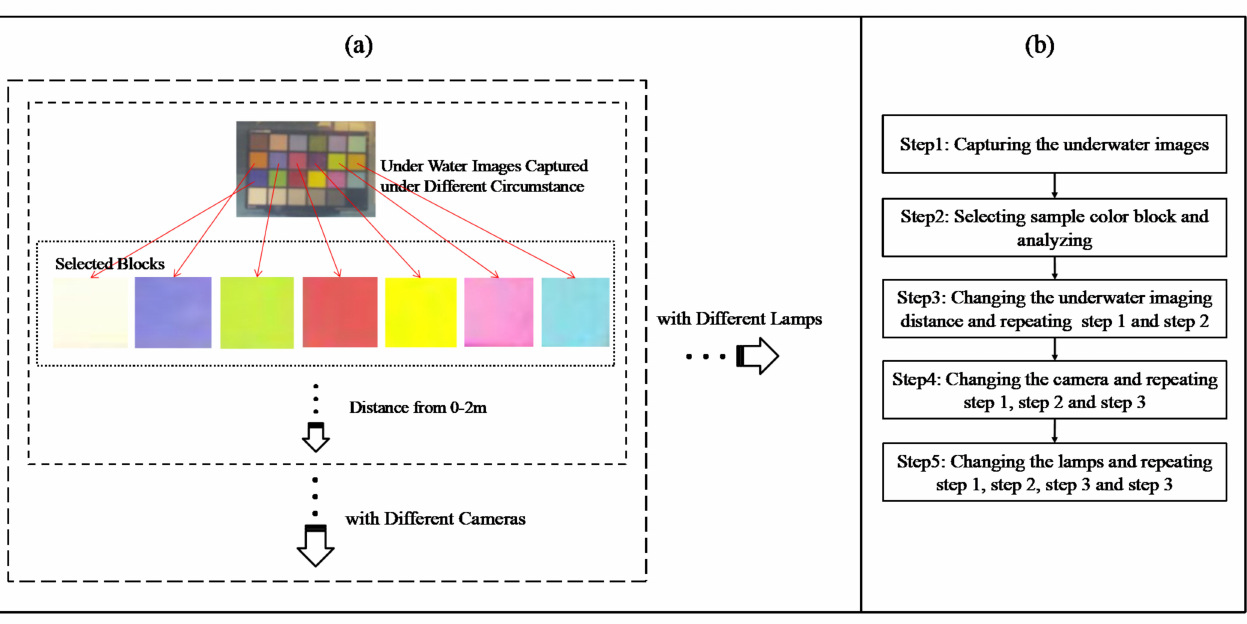
Figure 8. The process of acquiring experiment data: ( a ) the sketch map of data acquisition; ( b ) the flow chat of data